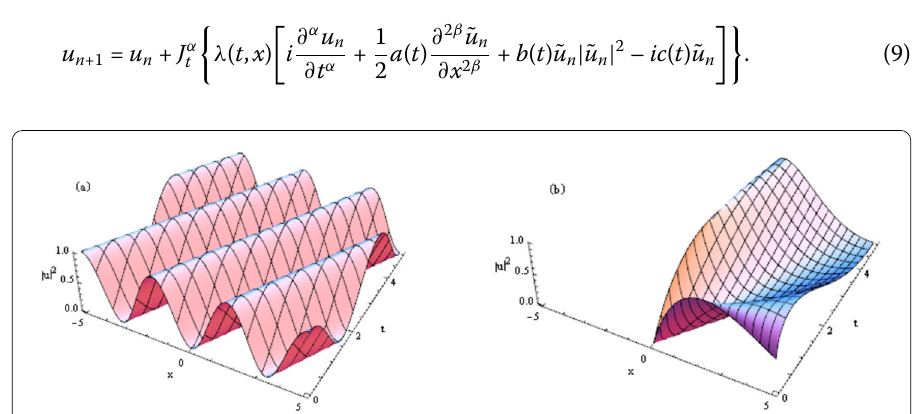
Figure 1 ( a ) The evolution plot of the exact doubly periodic solutions u 12 with the parameters k = k 1 = k 2 = A 1 = 1, a ( t ) = 1, c ( t ) = 0, m = 0.2, α = β = 1. ( b ) α = 0.5, β =